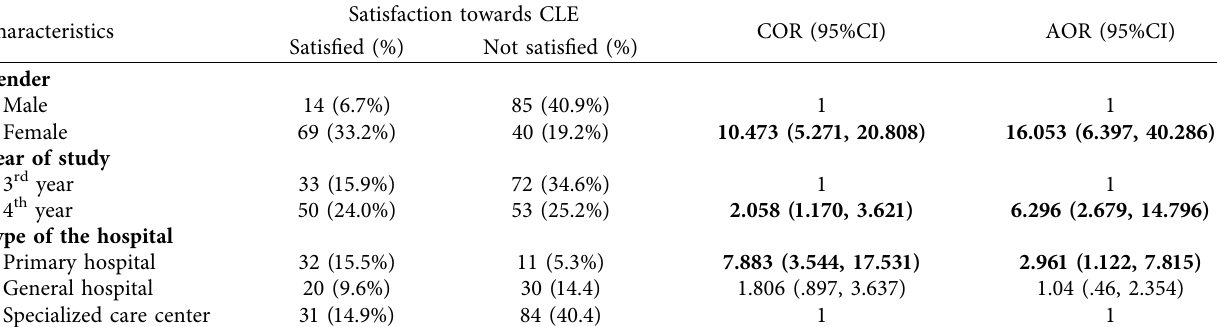
Table 3: Multivariable logistic regression results showing factors associated with the satisfaction level of nursing students towards CLE, Southern Ethiopia, 2021 ( n �